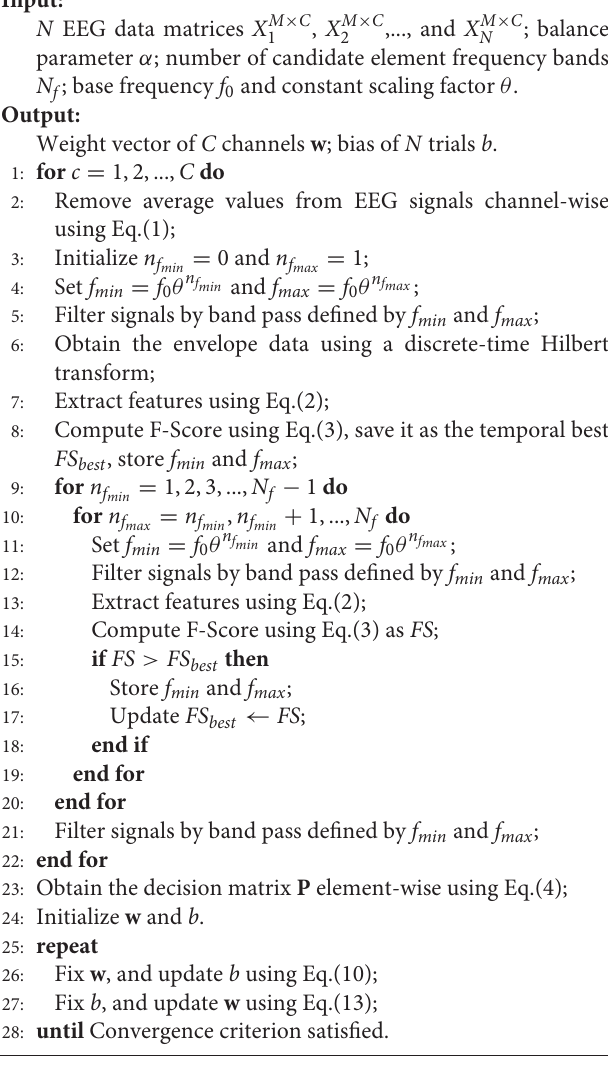
Algorithm 2 is O ( MNCN 2